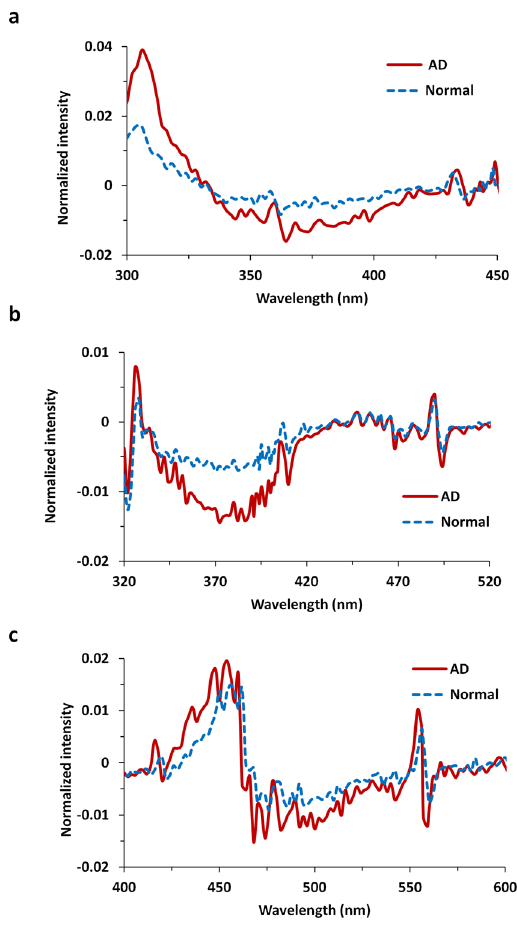
Figure 4. Means of the first derivative of fluorescence profiles of AD and N brain tissues at excitation wavelength ( a ) 266 nm, ( b ) 300 nm, and ( c ) 340